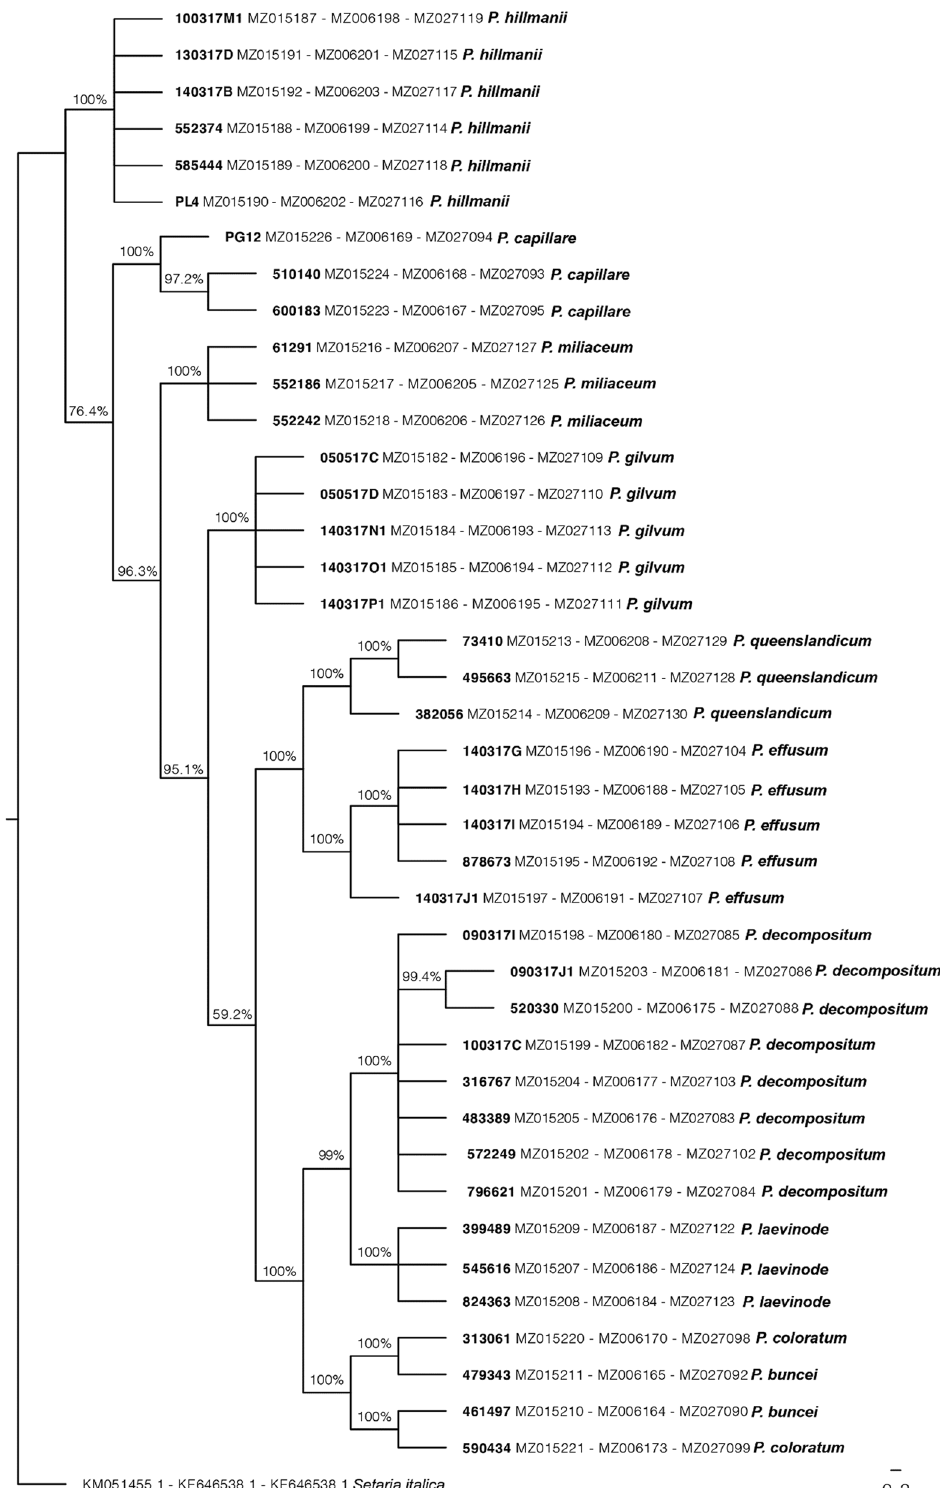
Figure 3. Bayesian phylogenetic relationships among ten Panicum species inferred from the concatenation of three conserved genetic sequences. Species ID on the terminal node was shown as voucher number GenBank accession number ( ITS-MatK- trnL intron trnF ) and species name. Clade posterior probability is indicated at nodes. Accession identifiers are shown in